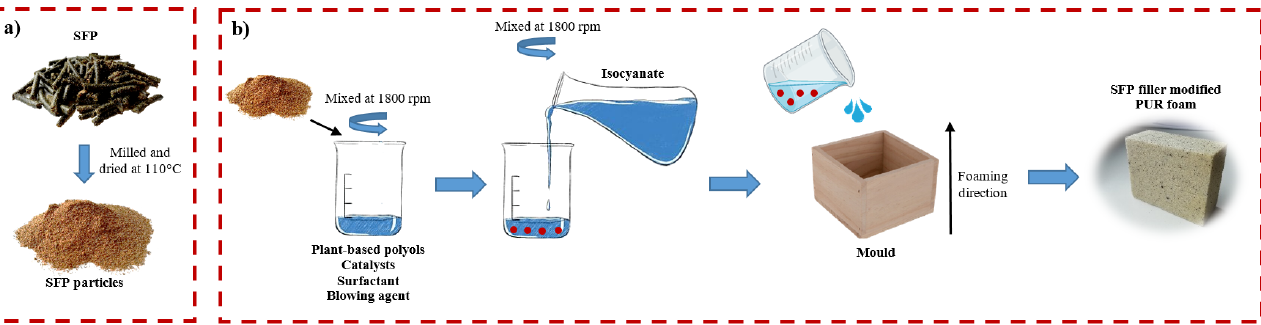
Figure 1. Graphical representation of the preparation scheme of: ( a ) SFP filler and ( b ) SFP filler-modified PUR